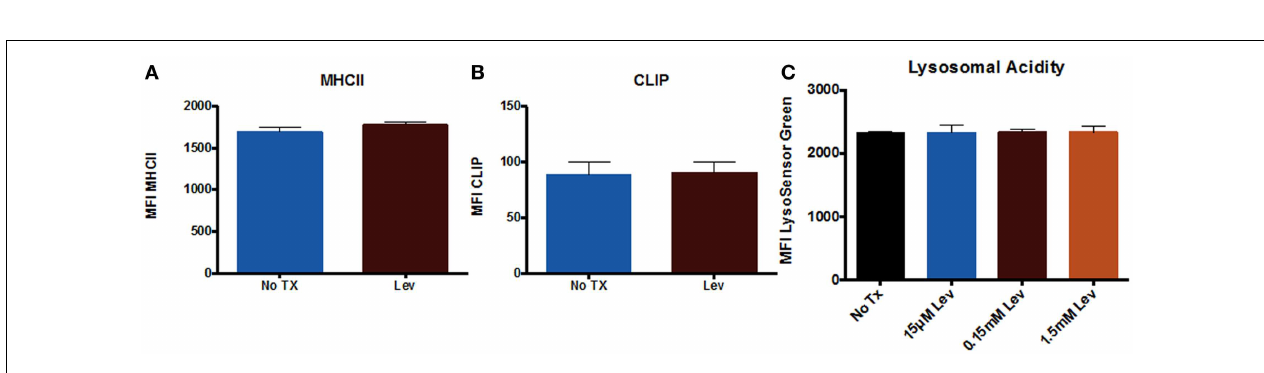
FIGURE 4 | Levetiracetam does not alter antigen processing and presentation machinery in vitro . Mean fluorescence intensity (MFI) as measure of relative expression level of (A) MHCII + and (B) CLIP on